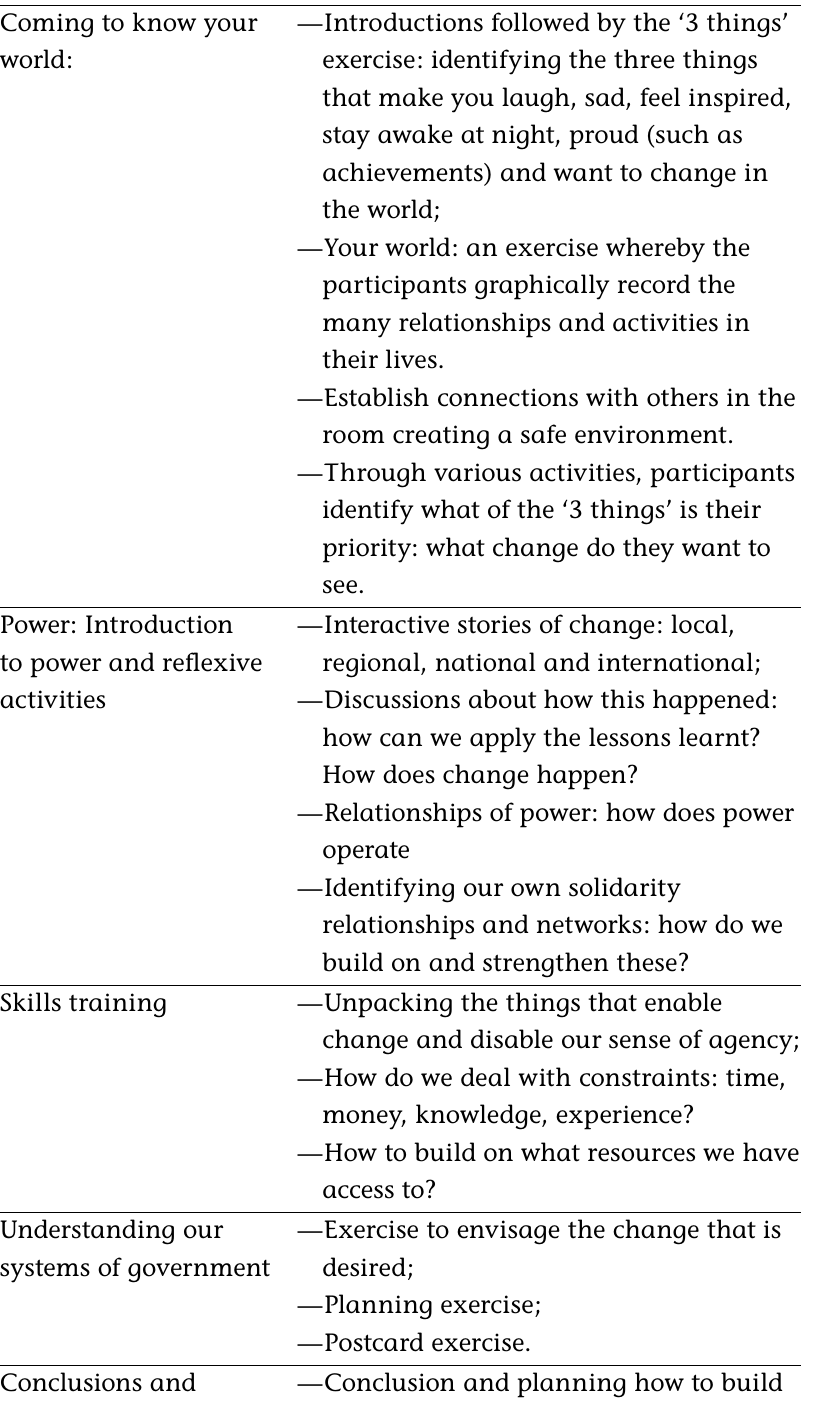
Table 2: Fair Trade